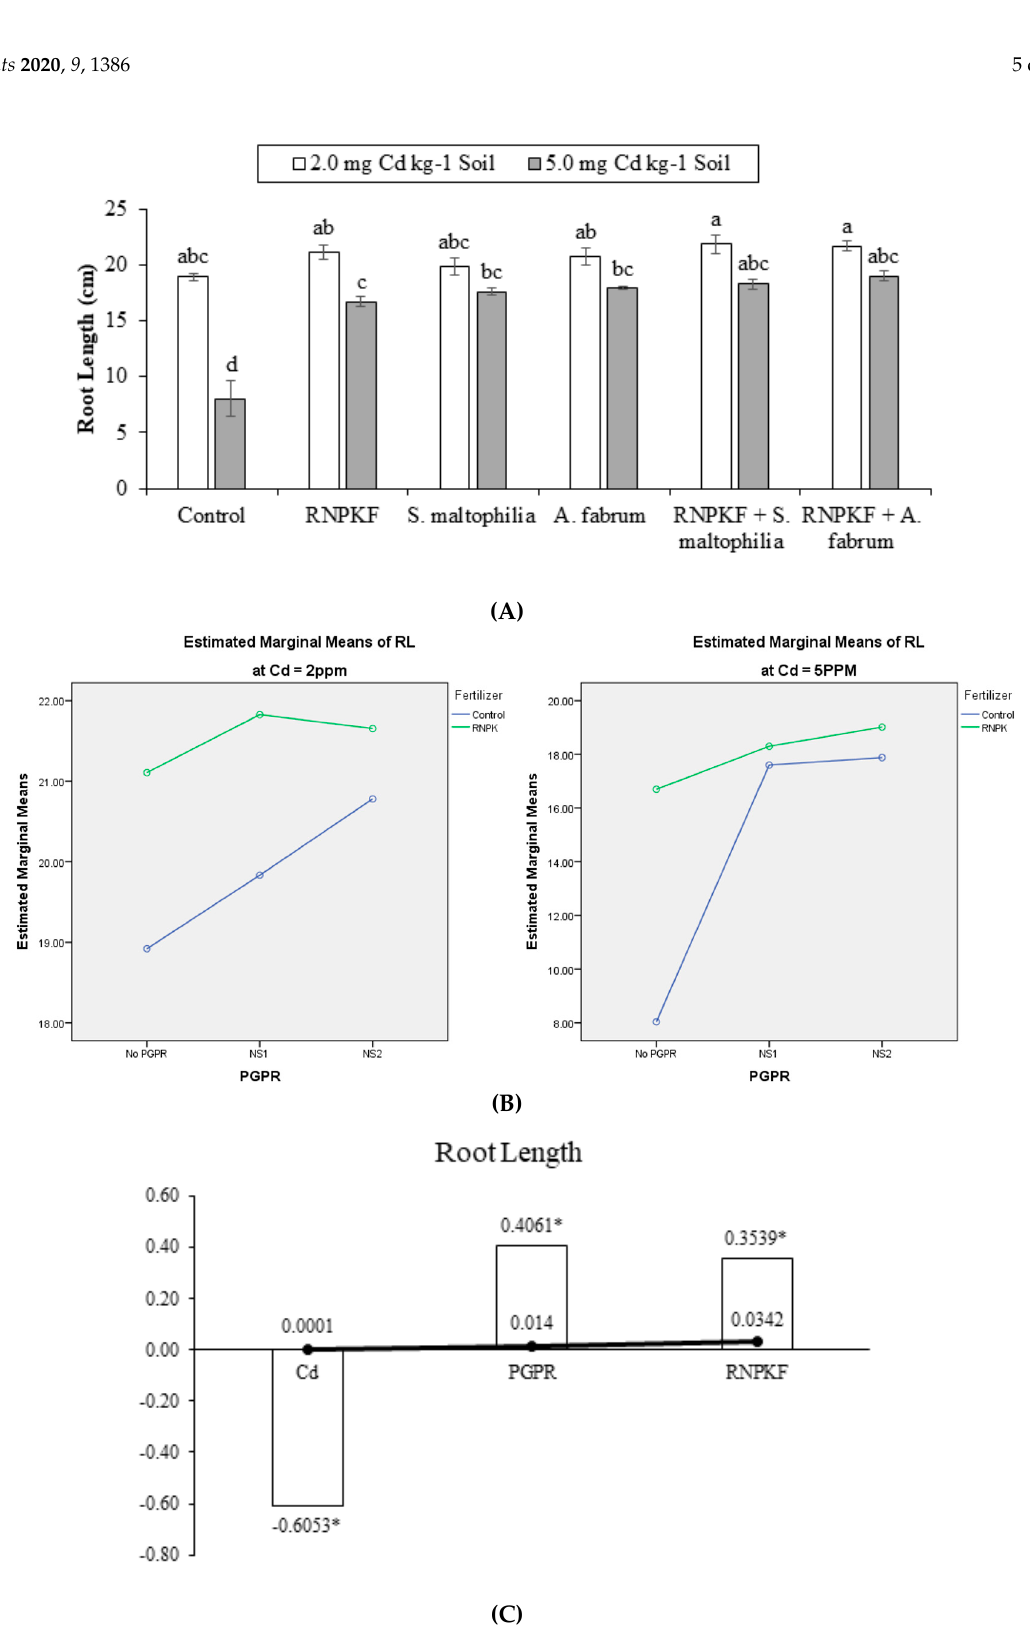
Figure 2. Effect of rhizobacteria with and without recommended NPK fertilizer on root length (RL) of bitter gourd under Cd ( A ). Interaction graph of PGPR (NS1 = S. maltophilia , NS2 = A. fabrum ), RNPKF and Cd levels for root length (cm) ( B ). Pearson correlation of root length with different levels of Cd, ACCD PGPR, and recommended NPK fertilizer where the y -axis represents the values of correlation (bars in the graph) and x -axis probability (lines in the graph) ( C ). * = p ≤ 0.05; ns = p > 0.05 non- significant.